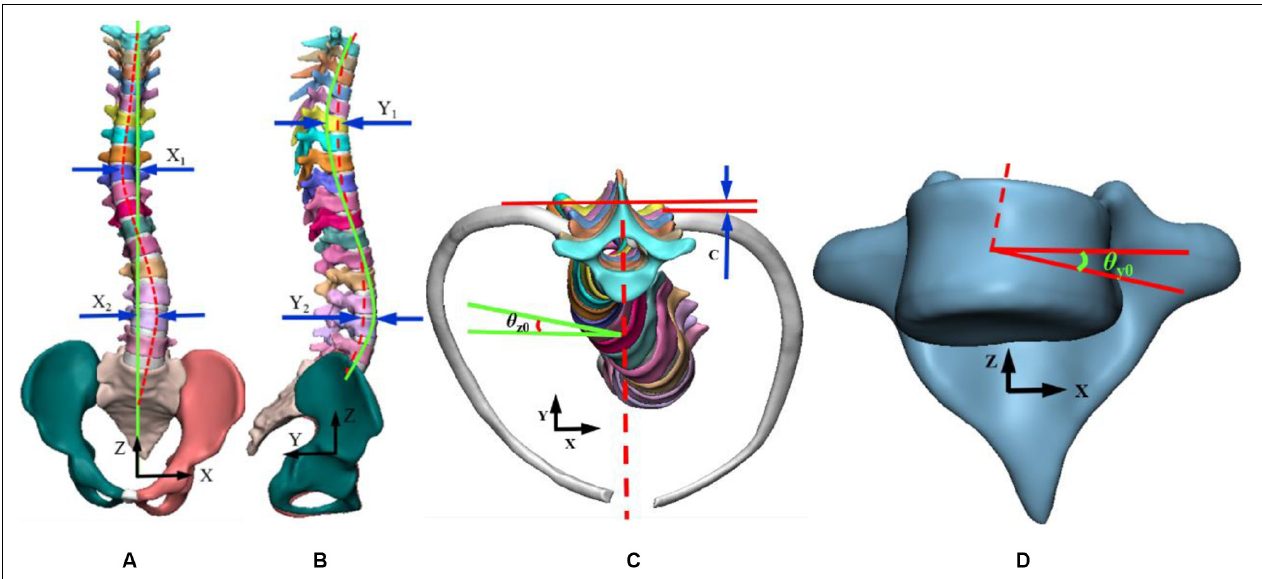
FIGURE 2 | Representation of variables in a three-dimensional view. (A) Coronal plan, (B) Sagittal plan, (C) Transverse plan, (D) Vertebral rotation angle.